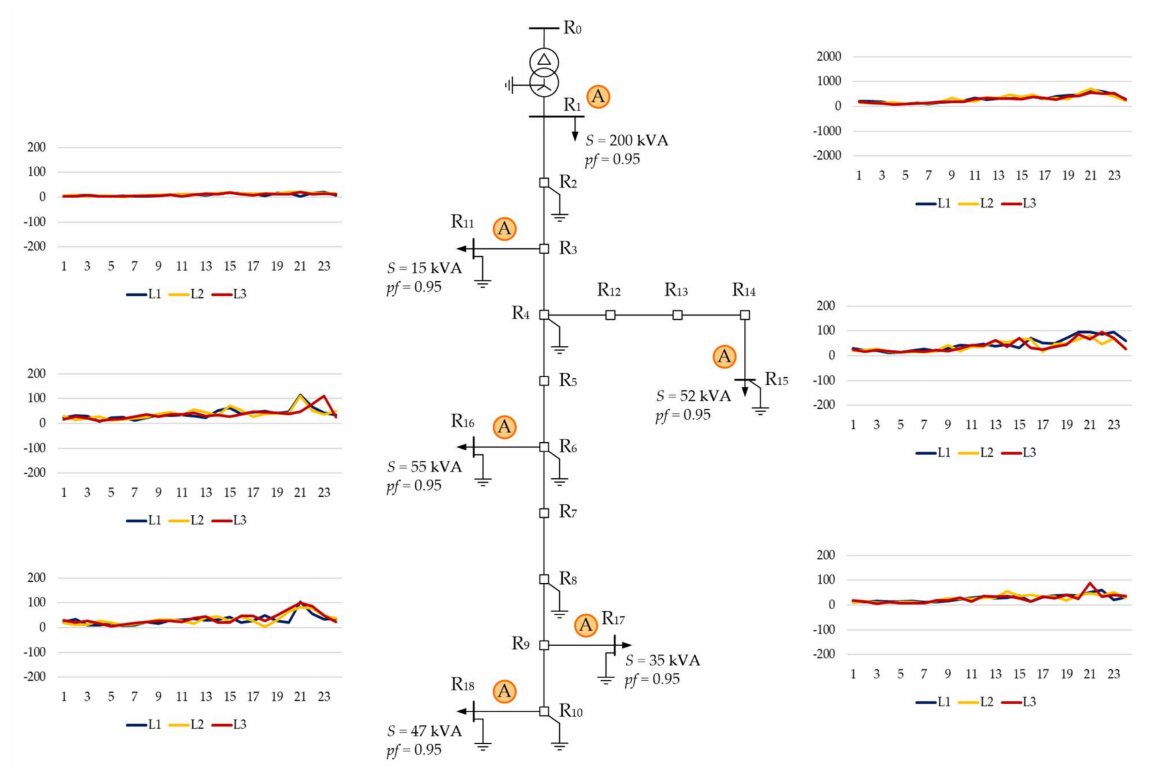
Figure A6. Daily simulation results for variant V6: phase currents